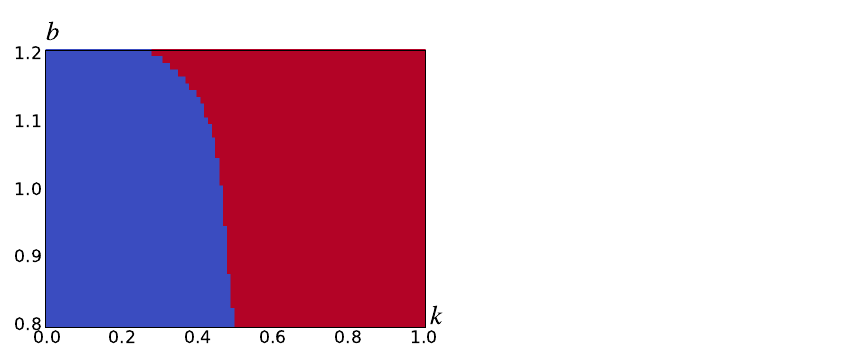
Figure 11. Basins of the 1.5 ↑ (red) and 2 ↑ (blue) patterns for Systems (1), (2) with a = d = e = 0.5, c = 1, D u = 5 × 10 − 4 , and D v =